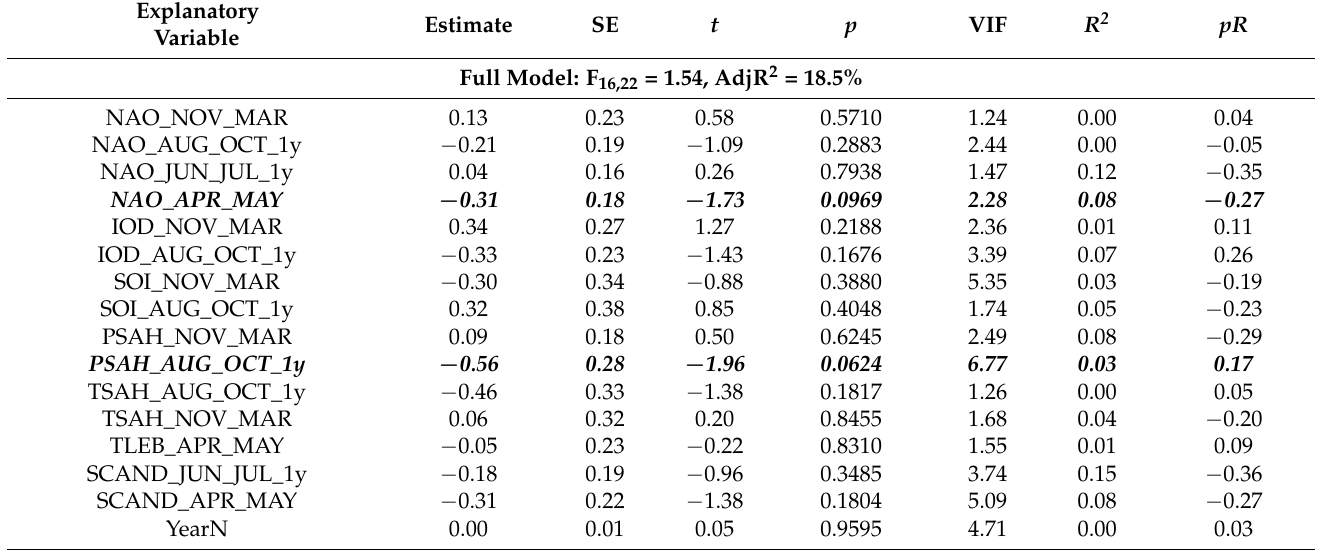
Table A8. Relationships between 15 climate variables and year in full models and Annual Anomaly of the timing of spring migration for the Chiffchaff Phylloscopus collybita caught at Bukowo, Poland, in 1982–2021. Symbols as in Tables 1 and A5. 0.05 < p < 0.1 in bold italics